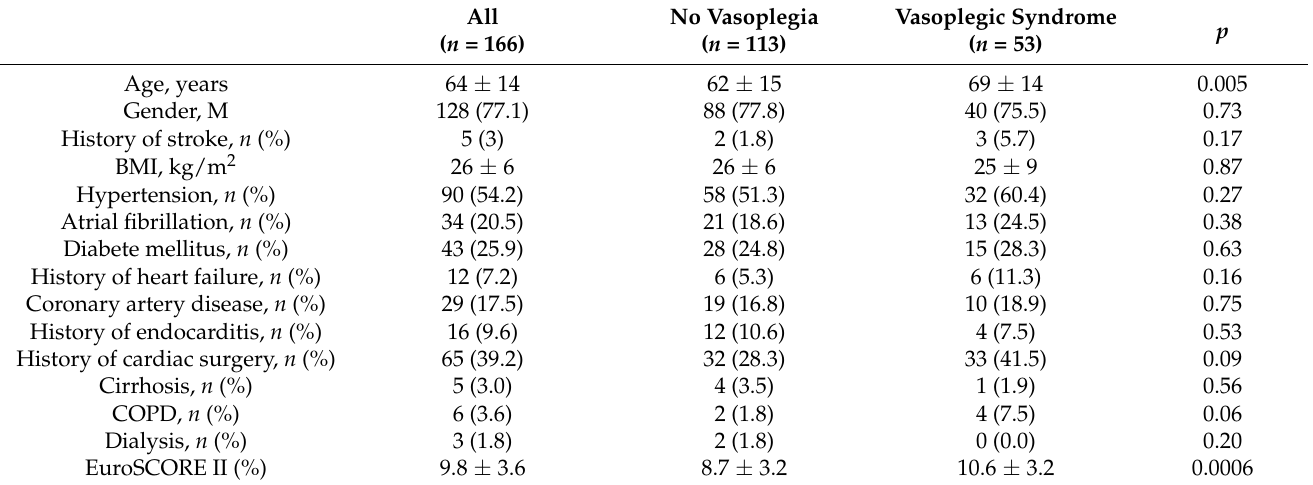
Table 1. Clinical characteristics of the population.